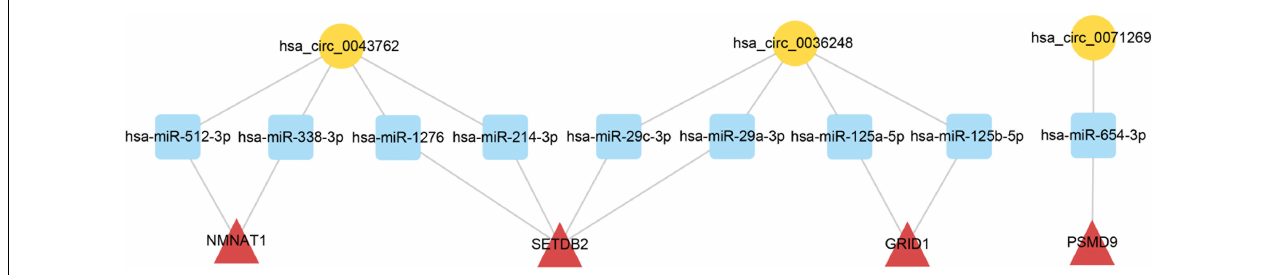
FIGURE 5 | CeRNA subnetwork of circRNA–miRNA–mRNA in HCM. Circular block represented circRNAs, square block represented miRNA, and triangle block represented mRNA. After identification of three HCM-associated circRNAs, a ceRNA subnetwork originating from these three circRNAs was constructed by integrated analysis. This ceRNA subnetwork included 3 circRNAs, 9 miRNAs, and 4 mRNAs. HCM, hypertrophic cardiomyopathy; circRNA, circular RNA; miRNA, microRNA; mRNA, messenger RNA; ceRNA, competing endogenous